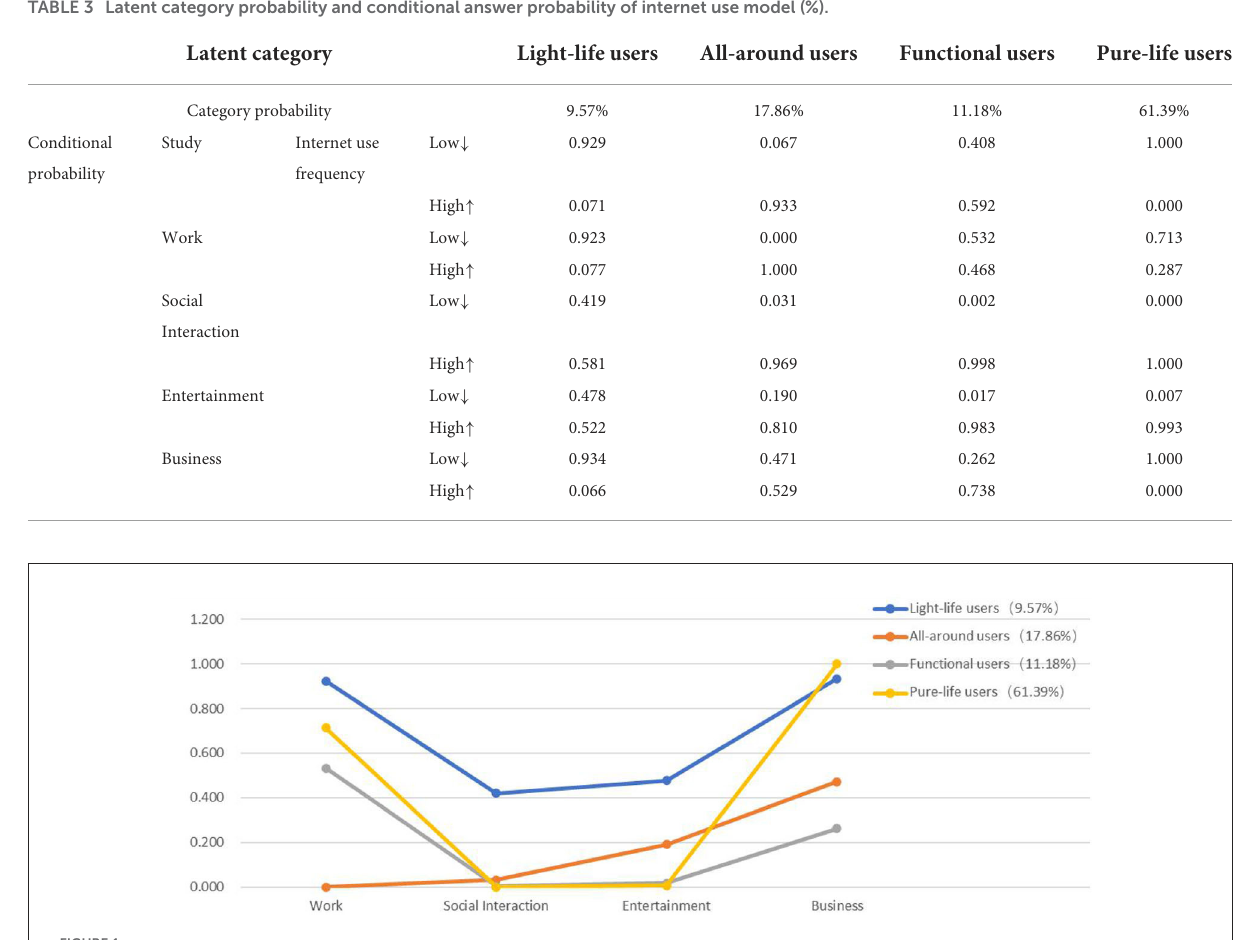
TABLE 3 Latent category probability and conditional answer probability of internet use model (%).